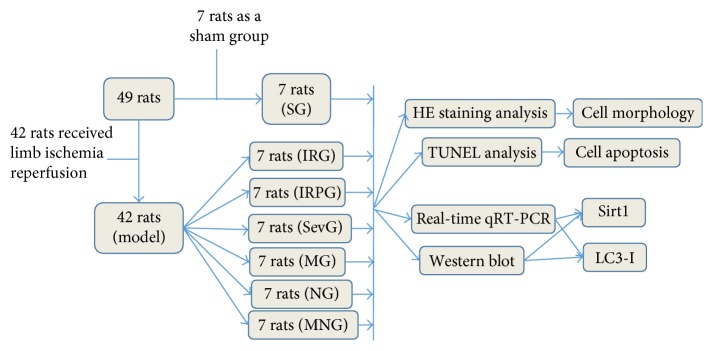
Study flowchart. SD rat models with myocardial cell injury (male, 8 weeks, weight 200 g~250 g) were divided into 7 groups: sham-operated group (SG), limb ischemia reperfusion group (IRG), limb ischemia reperfusion-preconditioning group (IRPG), sevoflurane-treated group (SevG), nicotinamide inhibitor-treated group (NG), 3-MA inhibitor-treated group (MG), and NAM+3-MA inhibitor-treated group (NMG).